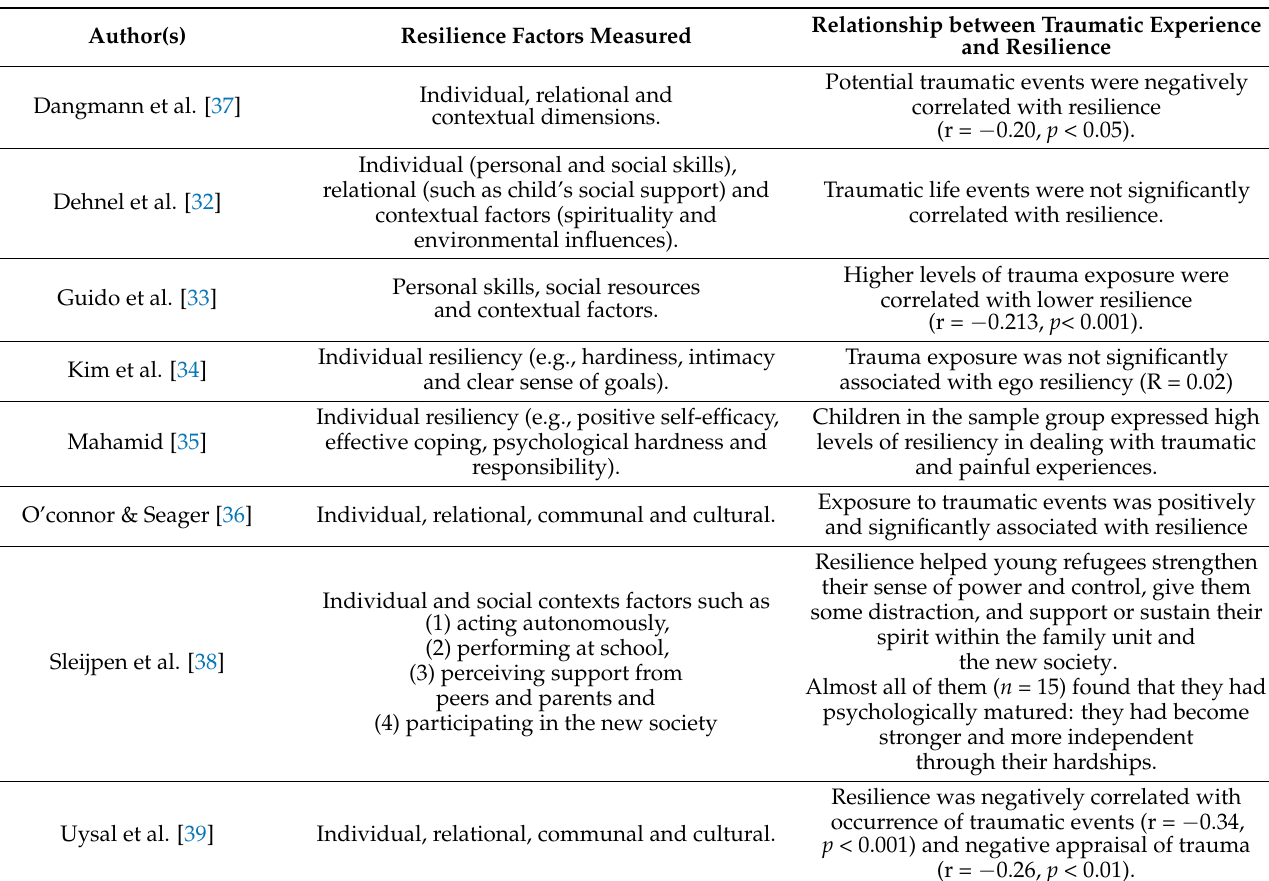
Table 2. Studies results on resilience factors measured and the relationship between traumatic experience and